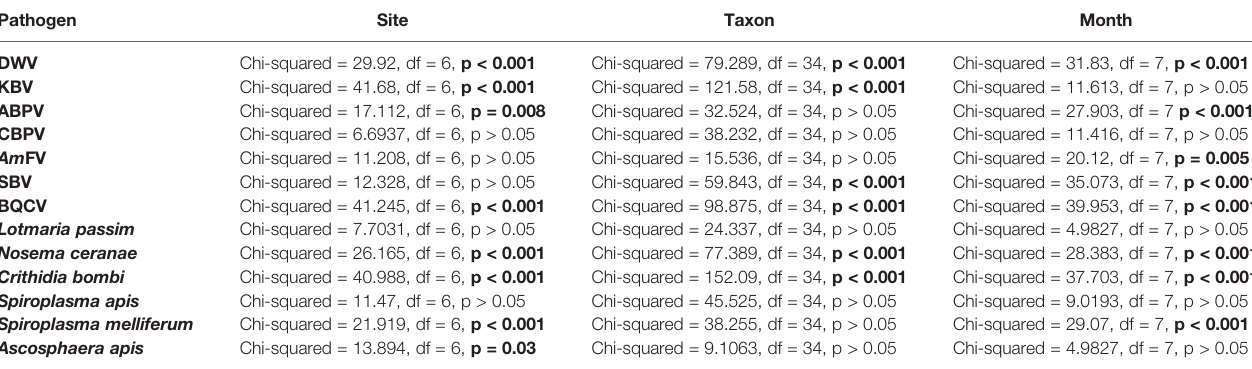
TABLE 5 | Signi fi cativity of the sampling site, taxon, and month of the collection as predictors of pathogen abundance (Kruskal – Wallis analysis). Pathogen Site